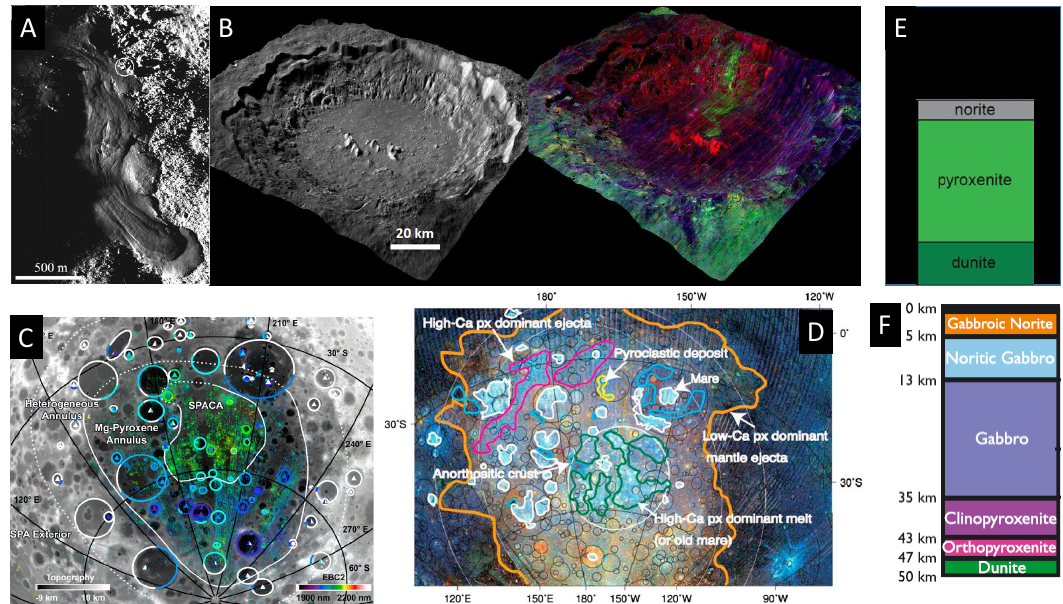
Figure 11. New views of impact melt deposits and SPA Basin. ( A ) High spatial resolution view of an impact melt flow deposit at Giordano Bruno crater (Source: [217]) . ( B ) Unique impact melt flow feature with no detectable topographic signatures (left panel), which is compositionally distinct (green feature on crater floor and northern wall) from surrounding impact melt on the floor (after [226]) . Red, green and blue colors map band strength at 1 µ m, 1.9 µ m and 2.3 µ m respectively. ( C , D ) Compositional zones at South Pole Aitken (SPA) basin (Source: [236,237]) . ( E , F ) Modeled mineralogical sequence at SPA based on the differentiation of an assumed impact melt sea (Source: [233,234])